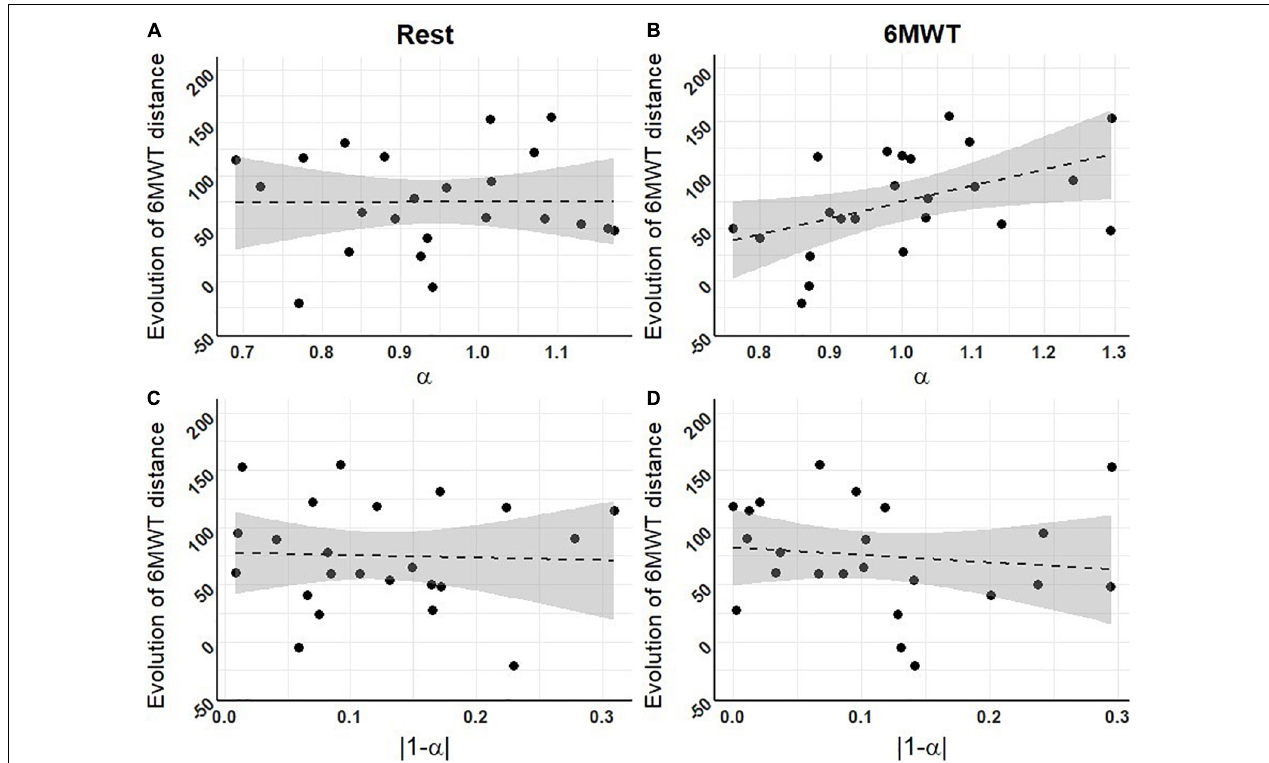
FIGURE 3 | Correlations between fractal exponents at T1 and the evolution of 6MWT distances throughout the PR program. (A) Level of complexity ( α ) at rest; (B) level of complexity during the 6MWT; (C) deviation from maximal complexity (|1- α |) at rest; (D) deviation from maximal complexity during the 6MWT ( n = 23 for A–D ). Dashed lines represent the regression lines, with confidence intervals in gray. Pearson correlation tests revealed one significant positive correlation between the exponent α of the R-R interval series during the 6MWT at T1 and the improvement in 6MWT distance over PR ( r = 0.47, p <